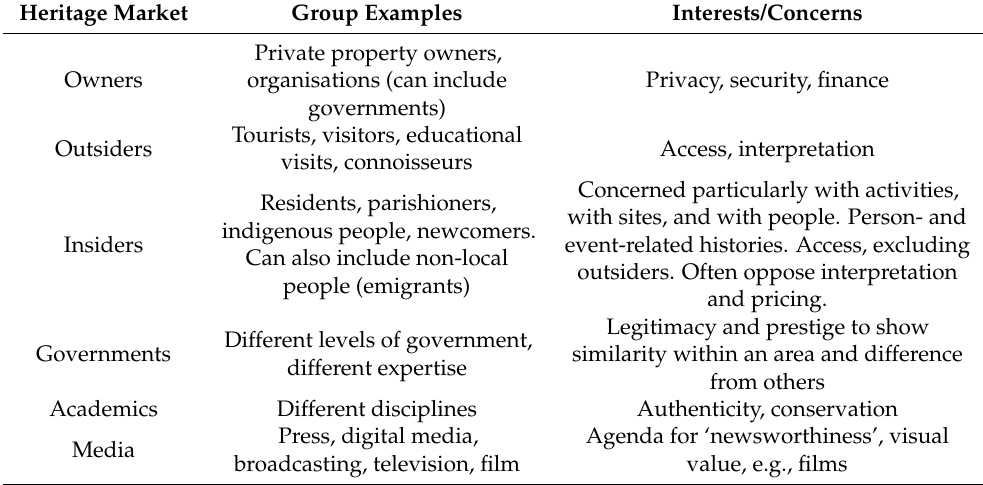
Table 1. Heritage markets, group examples, and interests/concerns adapted from Howard